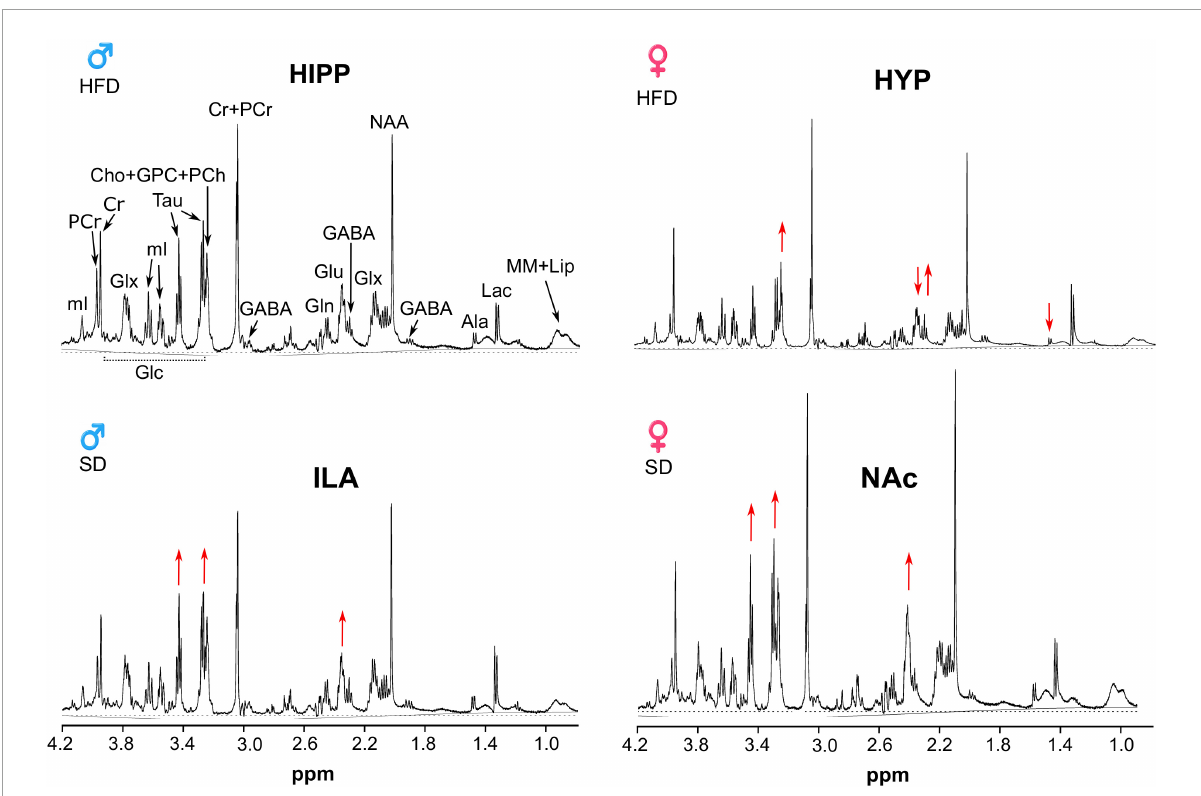
FIGURE9 1 H HRMAS spectra of representative female and male animals under SD or HFD. The hippocampus in a male HFD mouse (top left), hypothalamic region of a female HFD (top right), infralimbic area of a SD male (bottom left), nucleus accumbens (NAc) of a SD female (bottom right). Red arrows point the augmented or decreased signals characteristic of each region, such as the small Ala and Glu in the hypothalamus, or augmented Glu and Tau in the NAc or